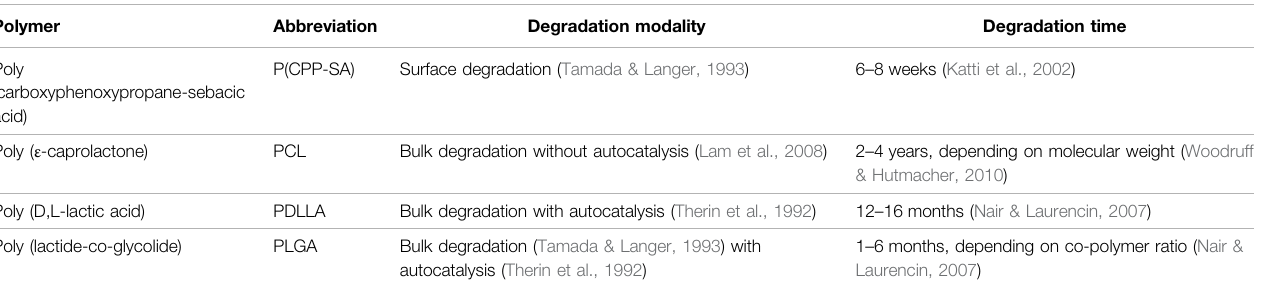
TABLE 2 | Degradation behaviors of some of the polymers that are commonly investigated in tissue